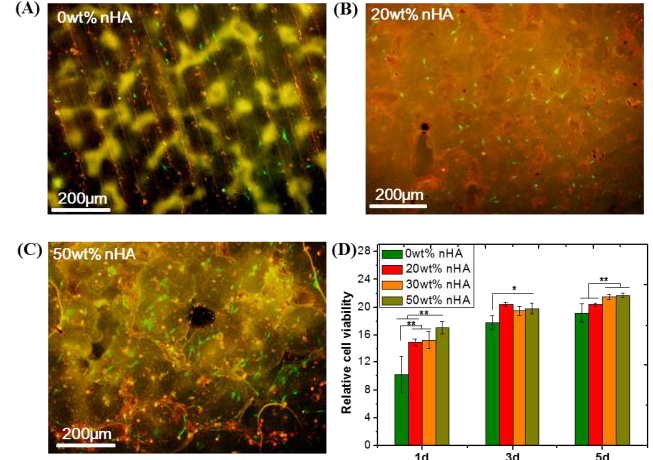
Figure 9. Osteoblasts biocompatibility investigation of the nHA-PBP hybrid membranes with dif- ferent nHA contents (20 wt% and 50 wt% nHA). MC3T3-E1 cell attachment morphology at 3 days